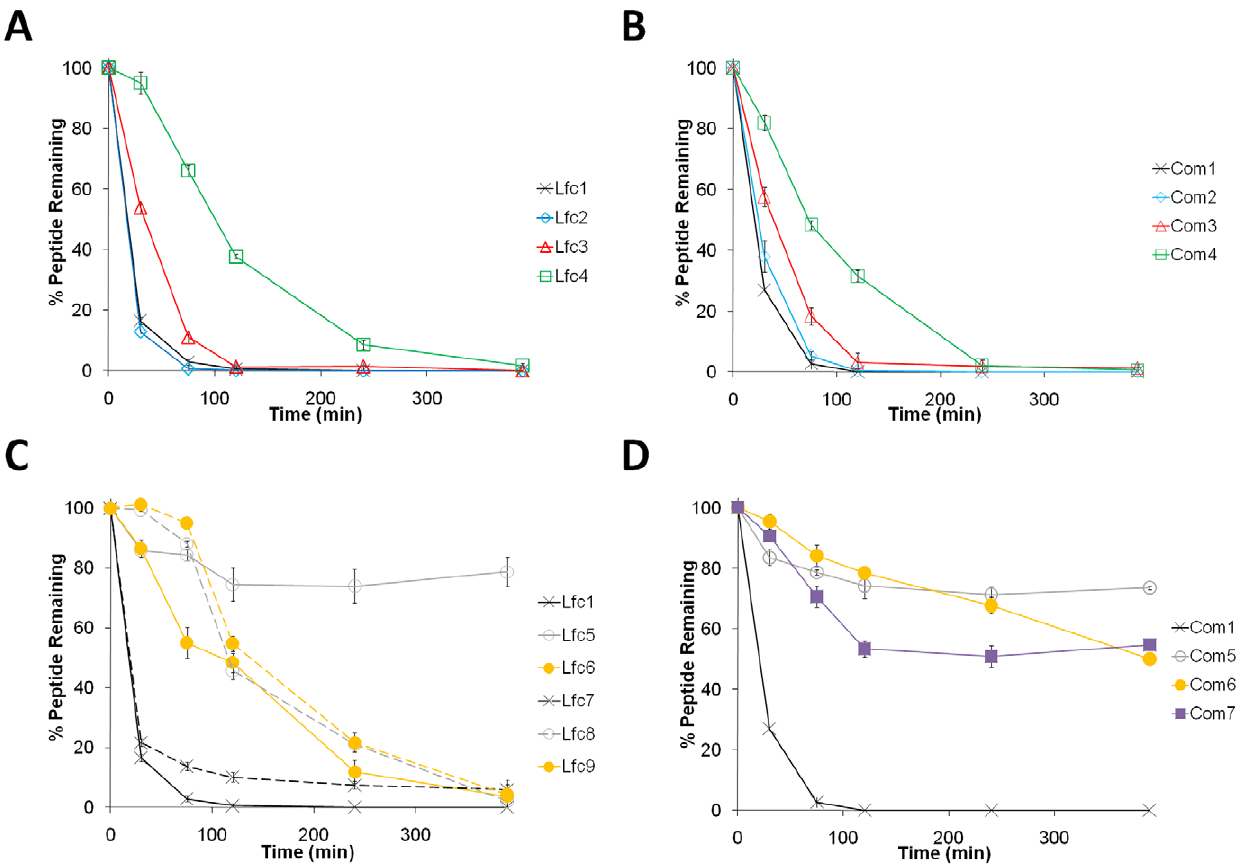
Figure 2. Serum stability profiles of the LfcinB- and Combi-based peptides. Relative peptide concentrations were determined by integration of the A215 peaks from RP-HPLC chromatograms. A) Linear LfcinB hexamers showing individual and combined effects of C- terminal amidation and N-terminal acetylation, B) Linear Combi hexamers with end caps C) Linear and cyclized LfcinB peptides comparing the end-to- end disulfide bridging and head-to-tail backbone cyclization strategies to different sized peptides, and D) cyclized Combi peptides. Assays were performed in triplicate.